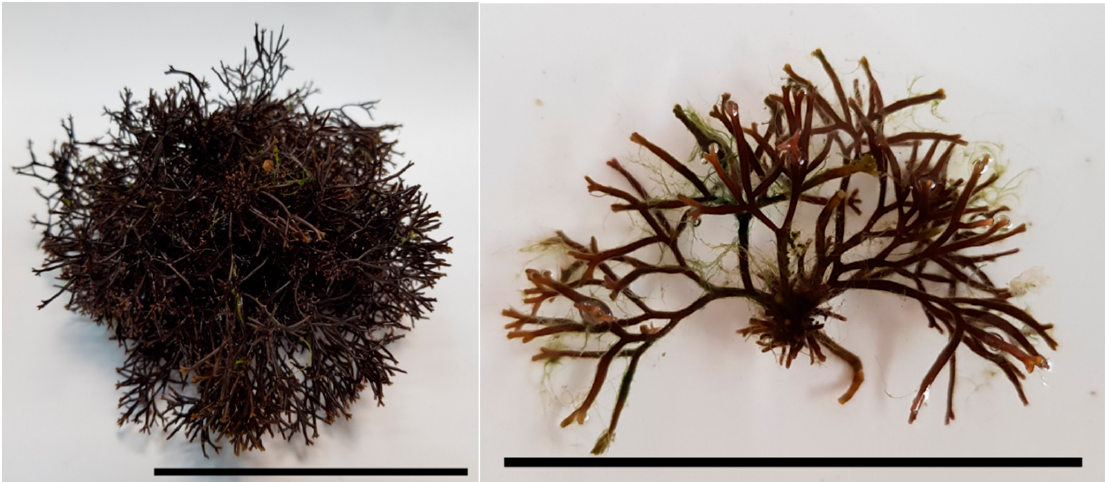
Figure 3. Furcellaria lumbricalis collected in Puck Bay in 2019. The line represents a distance of 10 cm.